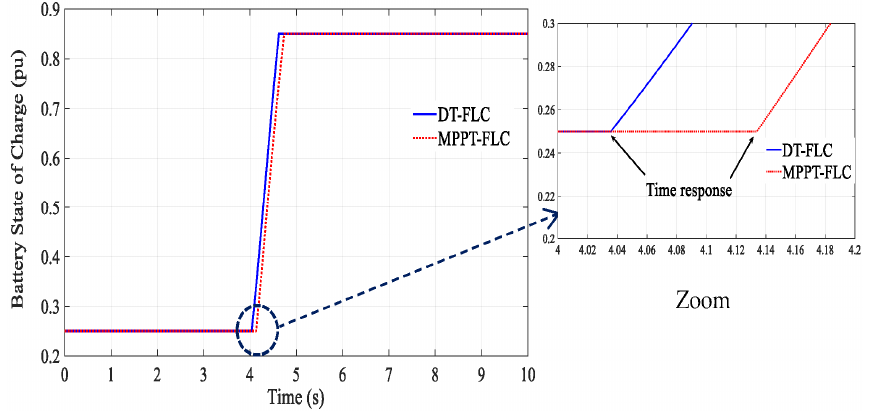
Figure 15. BESS participation in LVRT requirements.